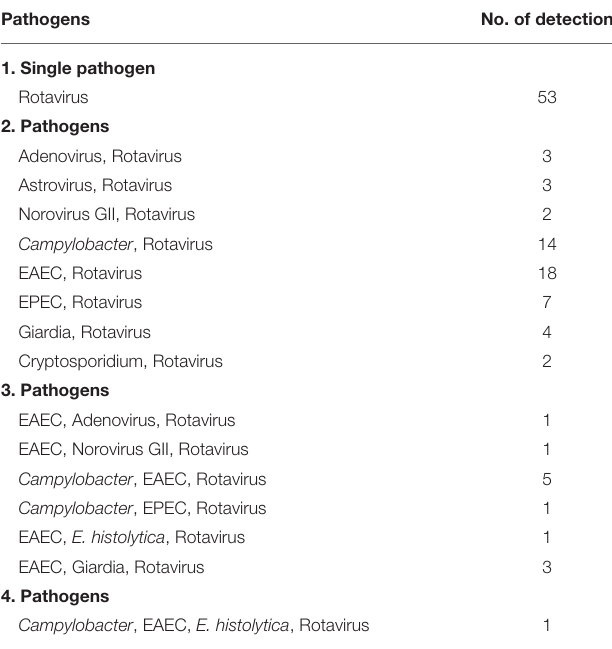
TABLE 2 | Coinfection of rotavirus with other enteric pathogens.